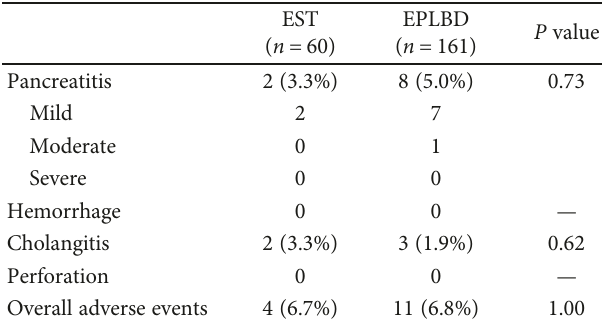
Table 3: Comparison of the adverse events between the EST and EPLBD